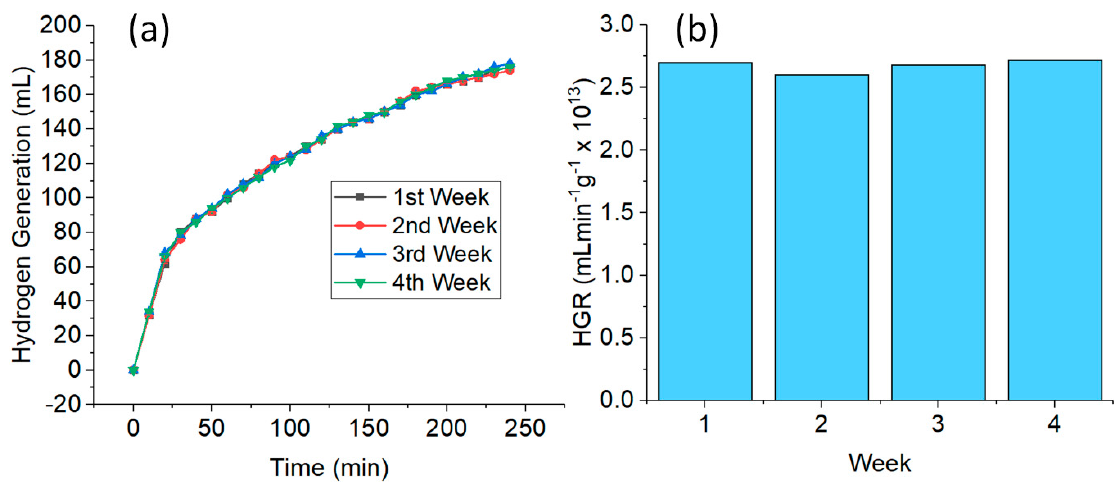
Figure 6. Plot of ( a ) H 2 generation versus time; and ( b ) HGR of the hydrolysis of NaBH 4 of the CuNWs strips for four weeks (conditions: CuNWs = 0.1 ng, 10 mL of [NaBH 4 ] = 1 wt%, pH = 12, and temperature = 298 K).